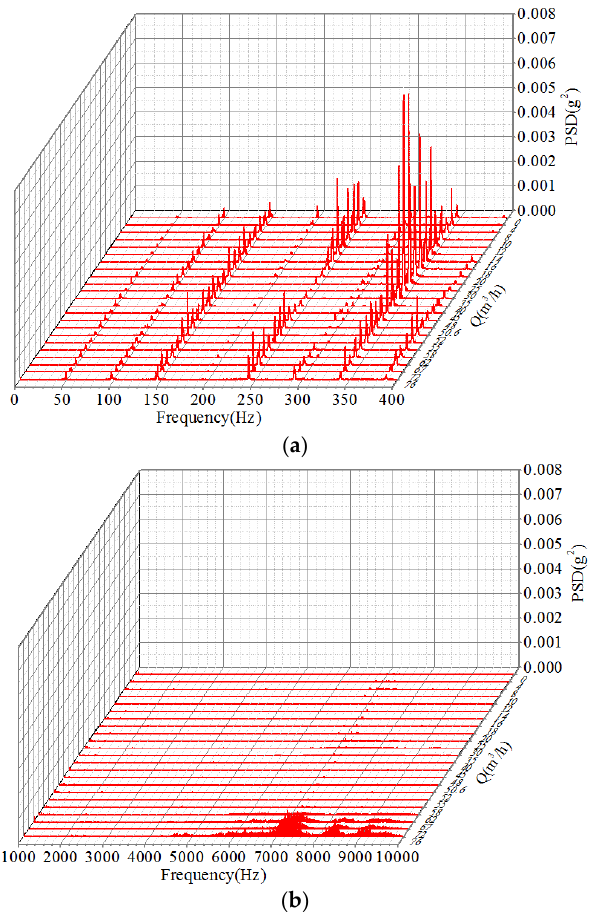
Figure 9. PSD of the vibration measured by accelerometer 3 under different flow rates. ( a ) 0 – 400 Hz, ( b ) 1 – 10 kHz.